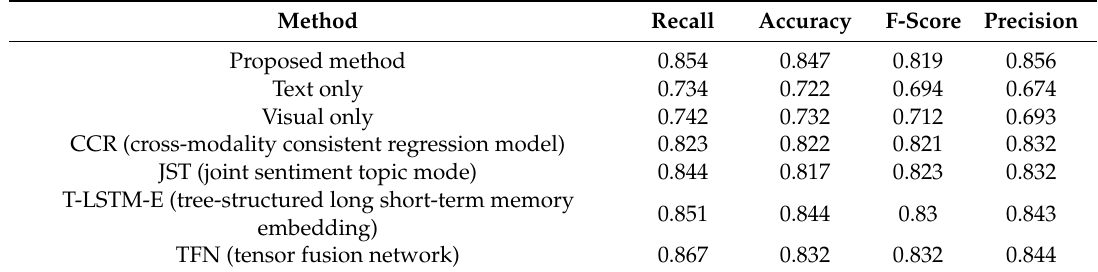
Table 1. Performance of various sentiment analysis methods on Flickr.